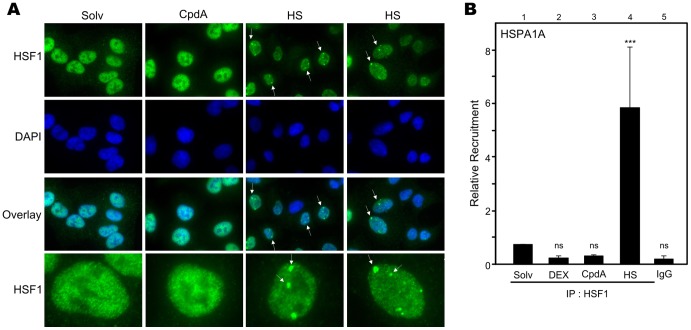
Compound A does not activate HSF1.(A) A549 cells, starved for 48h in Optimem, were treated with solvent (Solv) or CpdA (10µM) for 4h or heat-shocked (HS) at 43°C for 1h. Via indirect immunofluorescence using an α-HSF1 Ab, endogenous HSF1 was visualized (green) and DAPI staining indicates the nuclei of the cells (blue). We also present an overlay and in the panel below, we digitally zoom in on one cell. White arrow heads indicate nuclear stress granules or foci of HSF1. This experiment is representative for 2 independent experiments. (B) A549 cells, starved for 48h in 0% DMEM, were treated with Solv, CpdA (10µM) or DEX (1µM) for 2h or HS at 43°C for 1h. Total cell extracts were subjected to a ChIP assay targeting HSF1. Ensuing, qPCR signal of immunoprecipitated HSPA1A gene promoter fragments is presented relative to input data. Binding to rabbit IgG represents aspecific binding. Statistical analysis (ANOVA with Tukey’s multiple comparison post test) was performed to show significant difference with the Solv condition (ns not significant; *** p<0.001). This experiment is representative for 2 independent experiments.